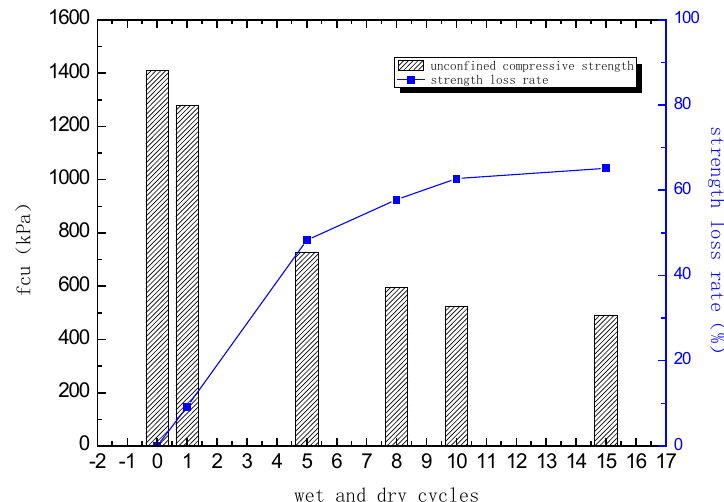
Figure 5. Intensity variation in 4G8S10 under different wet and dry cycles.